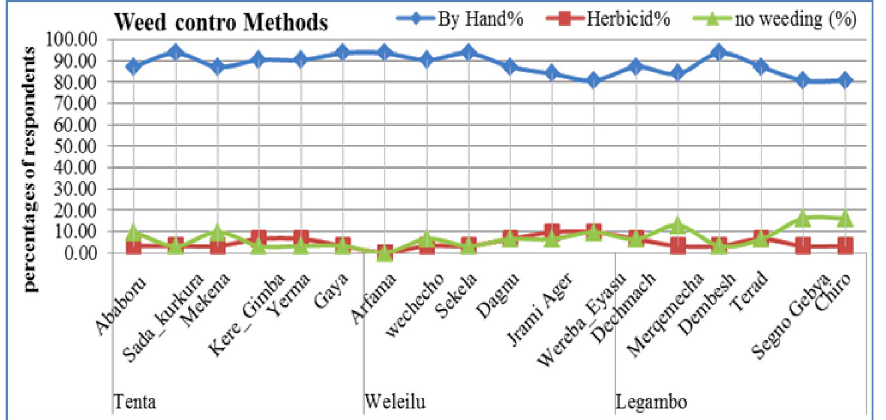
Fig 4. Weed controlled methods in the three districts and kebeles among